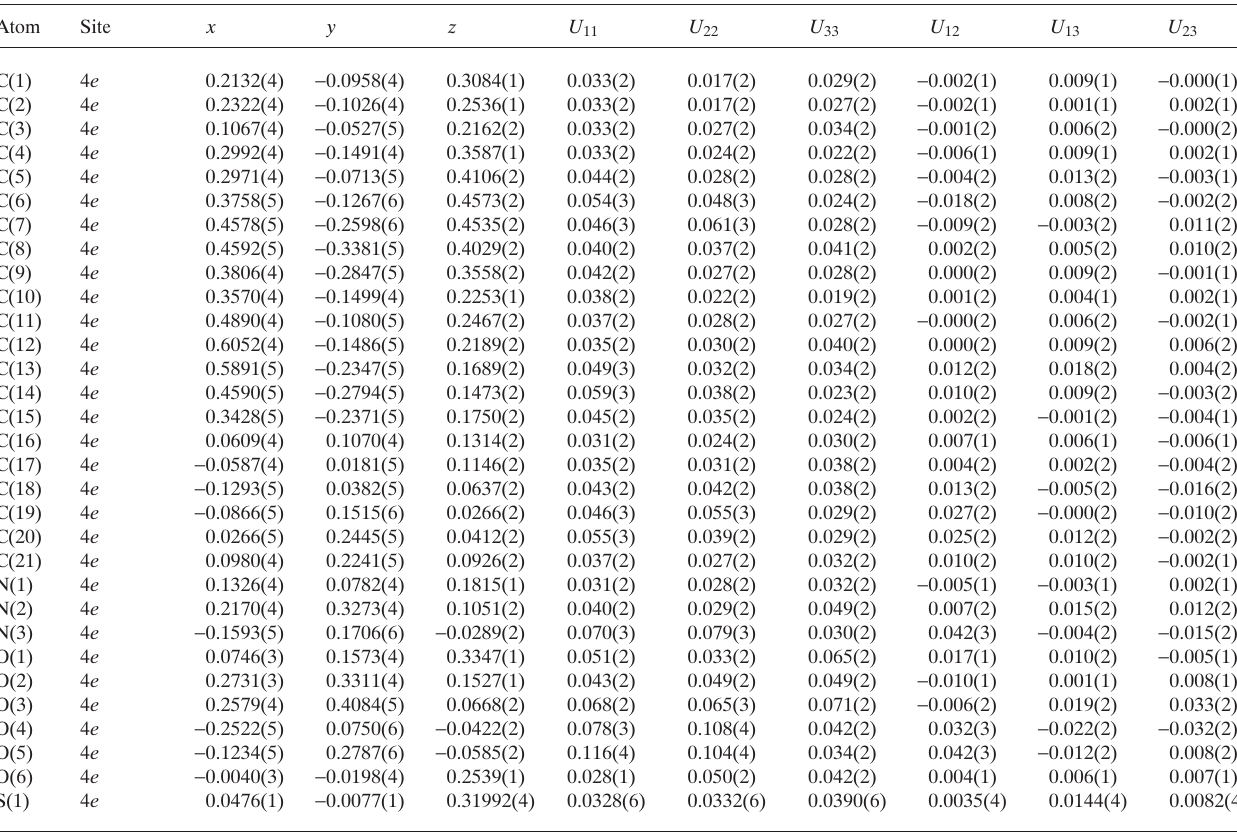
Table 3. Atomic coordinates and displacement parameters (in Å 2 )